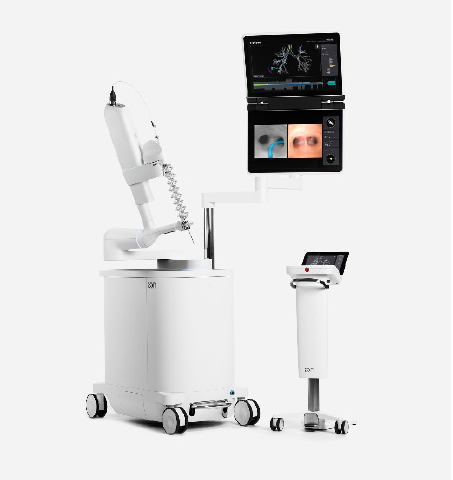
Figure 2. Ion™ Endoluminal System by Intuitive Surgical.